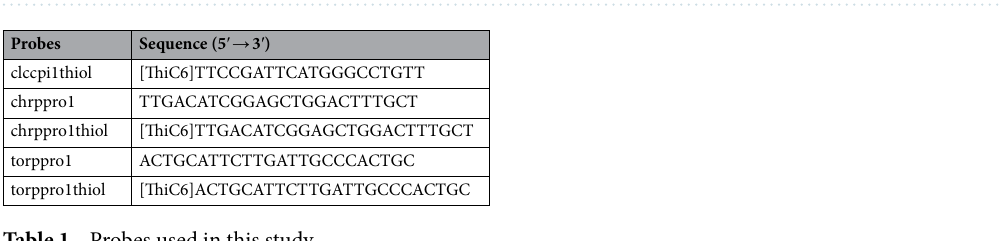
Table 1. Probes used in this study.